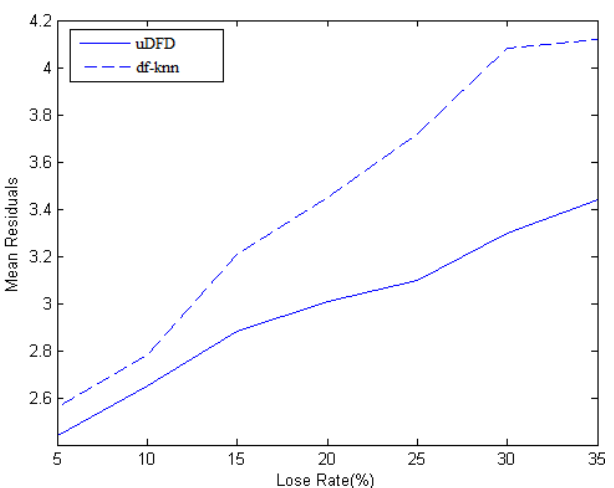
Figure 4. Effects of data